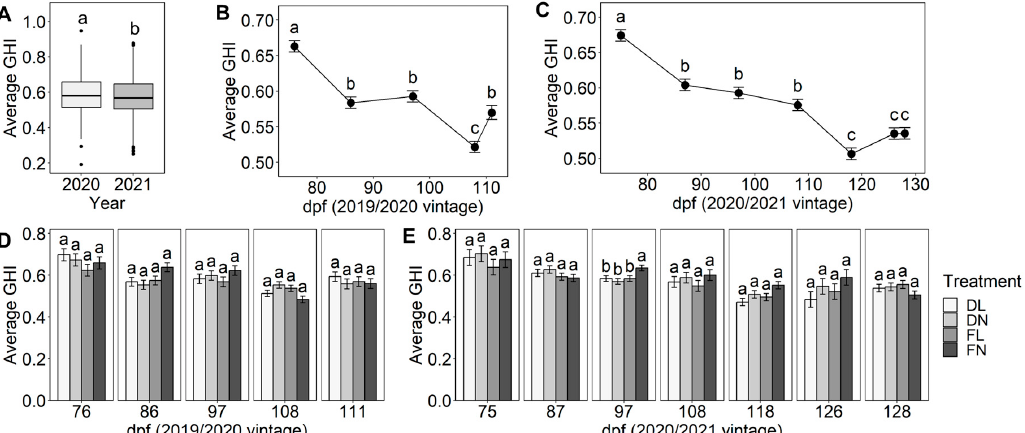
Figure 8. Changes in the bunch-to-bunch variability determined by GHI score according to ( A ) vin- tage and sampling date (dpf) per season for ( B ) 2019/2020 and ( C ) 2020/2021, and in response to crop load and irrigation regime ( n = 6 vines per treatment) for each sample date in ( D ) 2019/2020, and ( E ) 2020/2021. Bars/points and associated error bars represent the mean ± SEM of GHI score. Different lower-case letters for a given year or sampling date represent significant differences be- tween sampling dates or treatments (linear mixed model, α = 0.05, Bonferroni-adjusted). DL = de fi cit irrigation/low crop load, DN = de fi cit irrigation/normal crop load, FL = full irrigation/low crop load, FN = full irrigation/normal crop load (grower control).